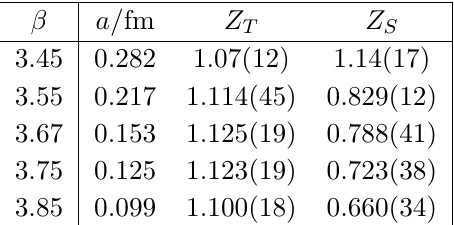
Table 1 . Conversion factors to the MS scheme at (cid:22) QCD = 2